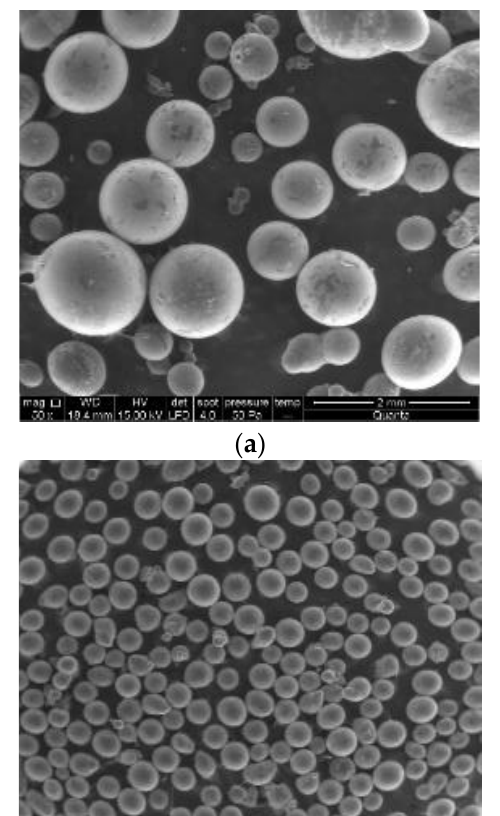
Figure 1. FT-IR spectra of the different synthesized particles: St-DVB (a), St-DVB-PEGMA (b), St-DVB-GMA (c), and St-DVB-GMA-PEGMA (d). Full spectra ( left ); Detail of the FT-IR in the range 3350 – 3600 cm − 1 ( right ).